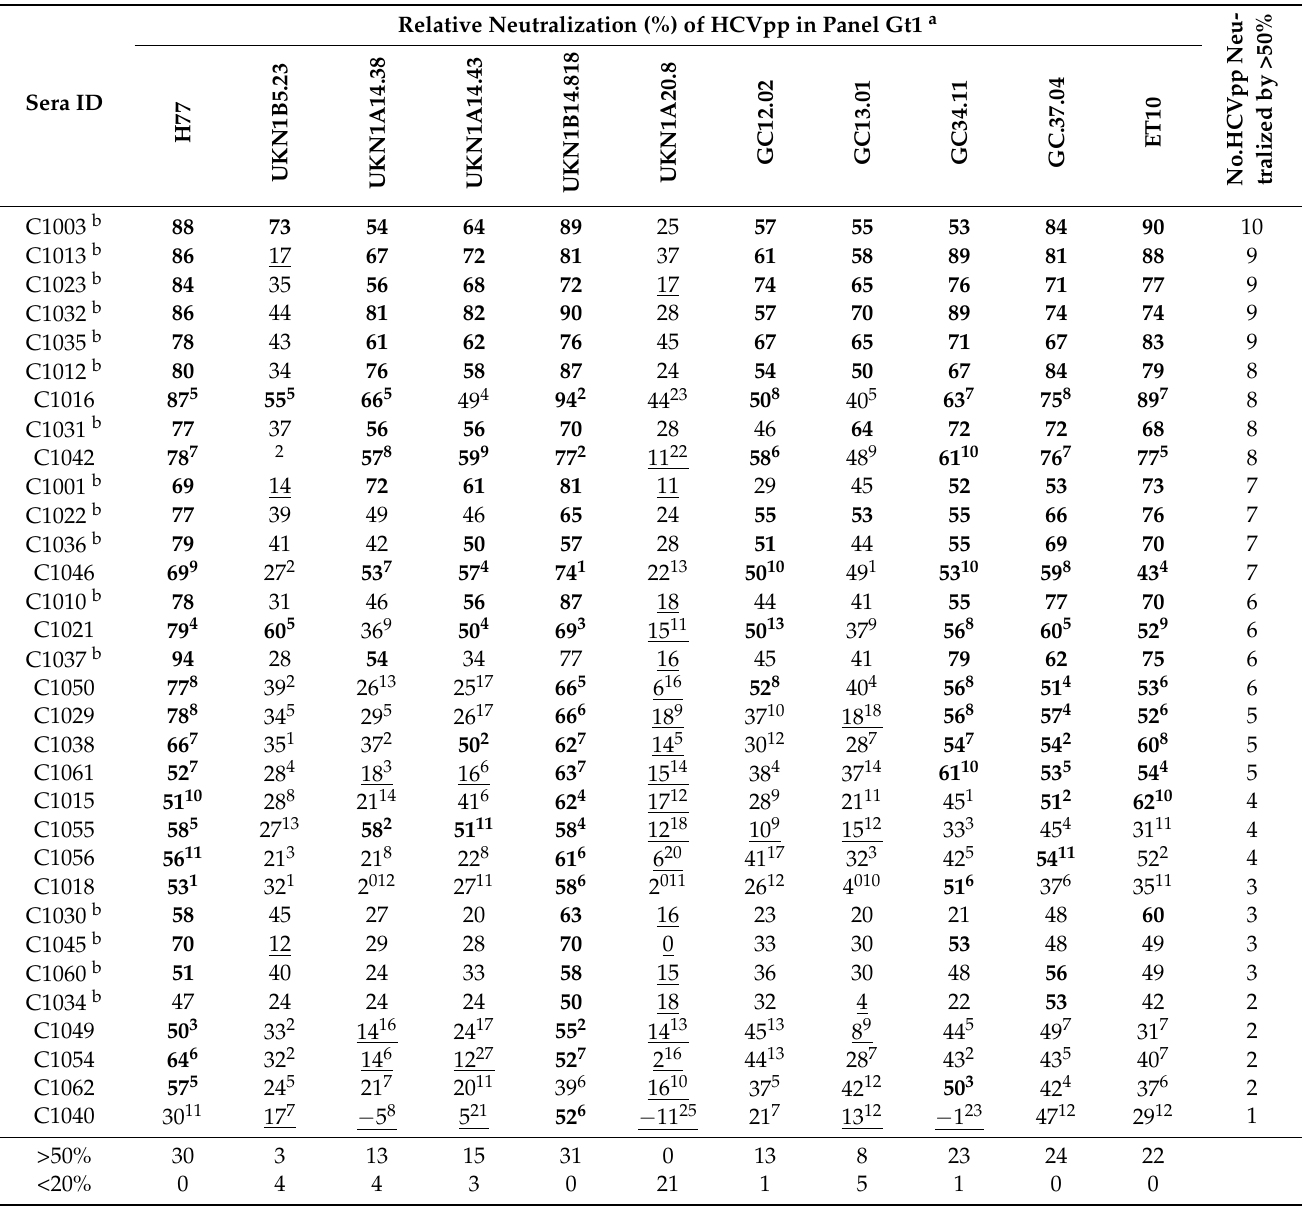
Table 3. Neutralization of CHCV cohort. The relative neutralization activity (%) of the Gt1 panel. The mean value from triplicate independent experiments is